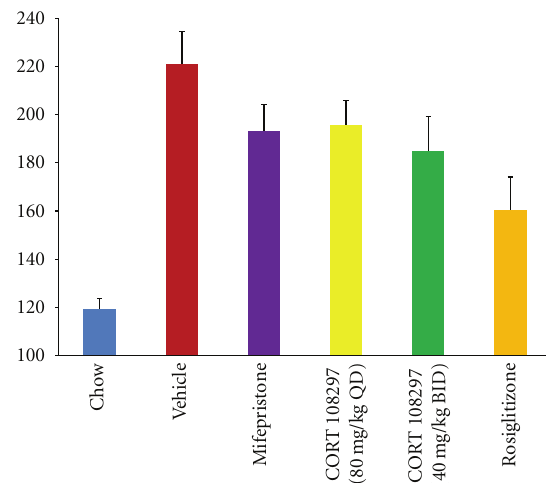
Figure 1: Mean body weight by treatment group. The mean body weights (grams) for the six groups of mice across the four week study. Vertical bars represent standard errors.